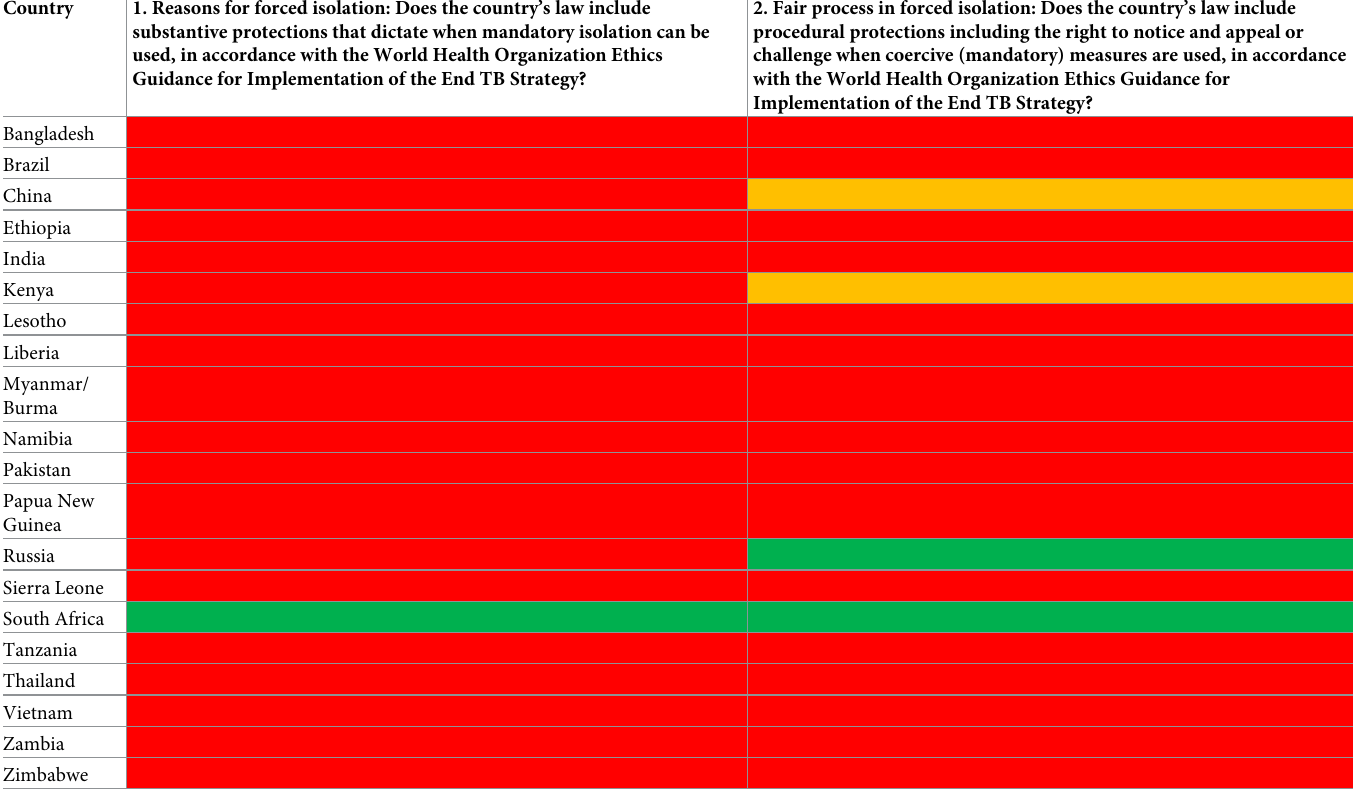
Table 1. TB-related laws on isolation. Country 1. Reasons for forced isolation: Does the country’s law include substantive protections that dictate when mandatory isolation can